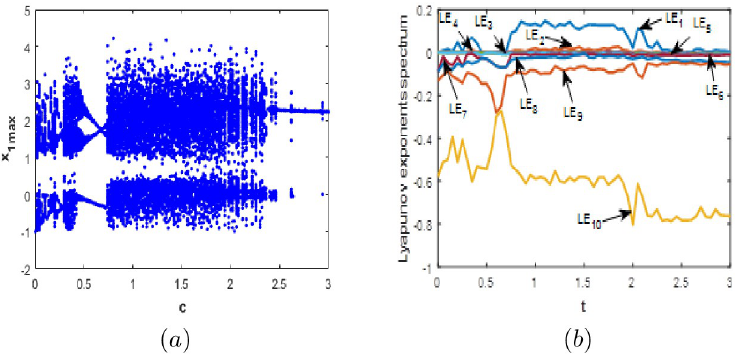
Fig 7. Bifurcation diagram (a) and Lyapunov exponents spectrum (b) of the new 10-D system (1) when: a = 0.1, b = 0.1, d = 0.01 and c 2 [0; 3].